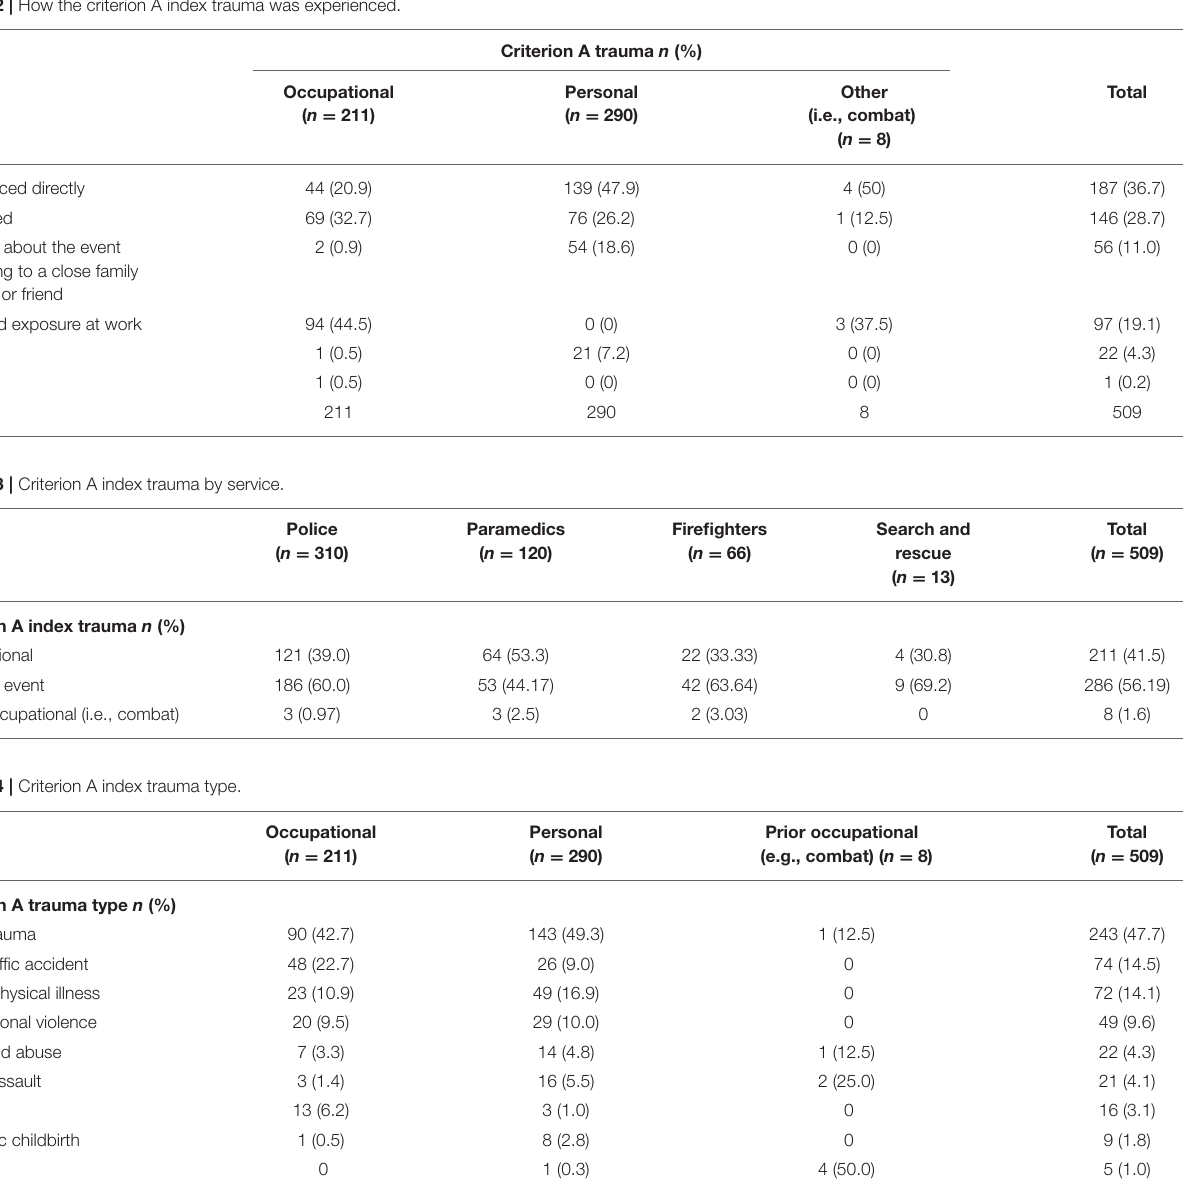
TABLE 2 | How the criterion A index trauma was experienced.